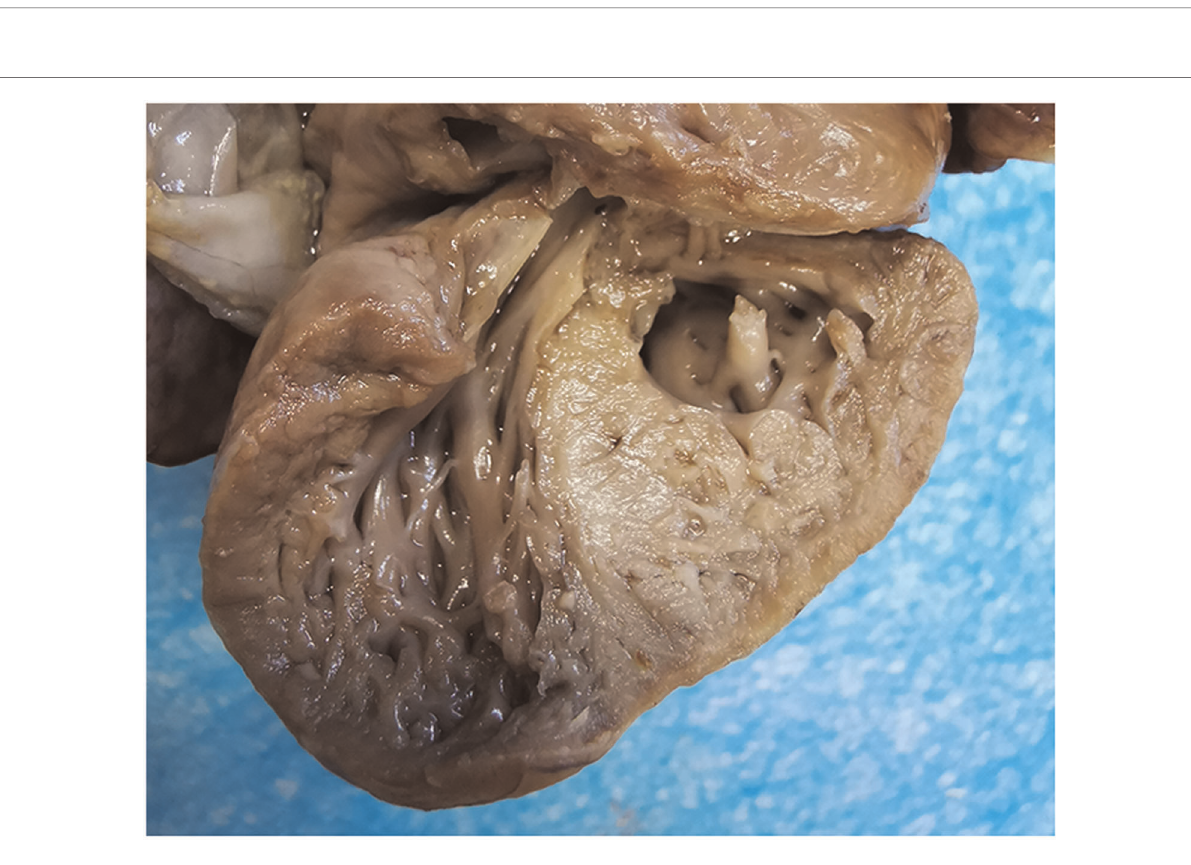
FIGURE 3 Dissected autopsy specimen. The specimen showed excessive trabeculae and deep intertrabecular recesses within the biventricular